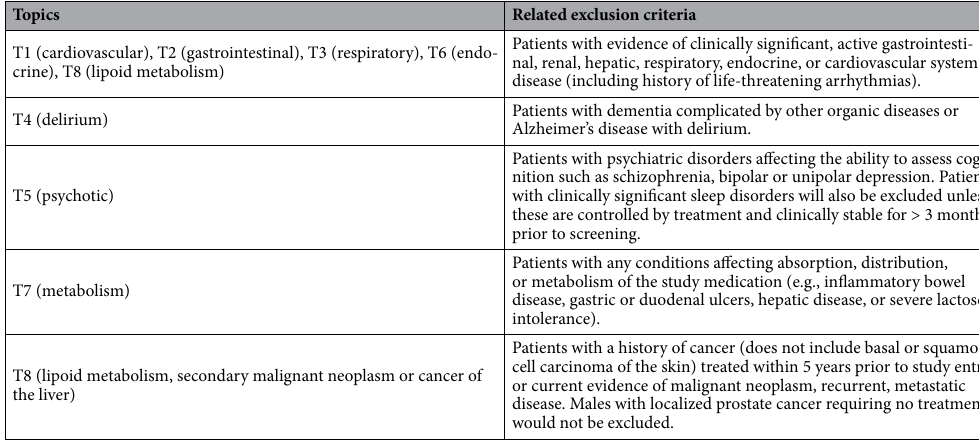
Table 3. Inferred topics and related exclusion criteria in the original donepezil trial (i.e.,